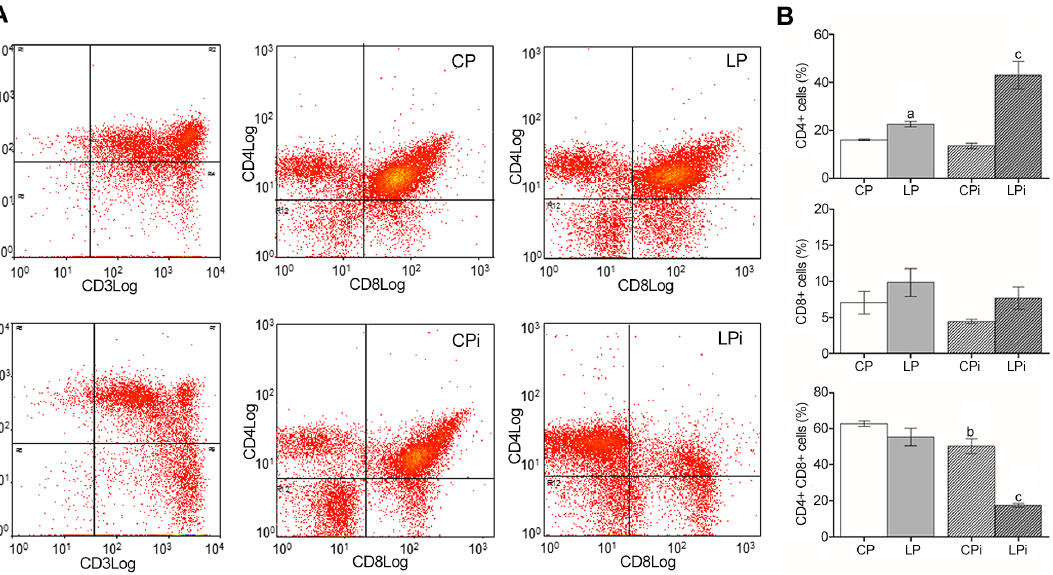
Fig. 5. Protein malnutrition dysregulated lymphocyte subpopulations in the thymus of mice infected with L. infantum . Lymphocyte subpopulations from the thymus of the experimental groups were measured using FACS analysis as described in the Materials and Methods. ( A ) Representative scatter plots of lymphocyte subpopulations. ( B ) Distribution of lymphocyte subsets expressed as percentage ¡ SEM. CP: animals fed 14% protein diet; LP: animals fed 4% protein diet, CPi: animals fed 14% protein diet and infected; LPi: animals fed 4% protein diet and infected. Two-way ANOVA analysis with Bonferroni pos-hoc test. Statistical differences due to diet: a (p , 0.05), infection: b (p , 0.05) and interaction between diet and infection: c (p , 0.05).